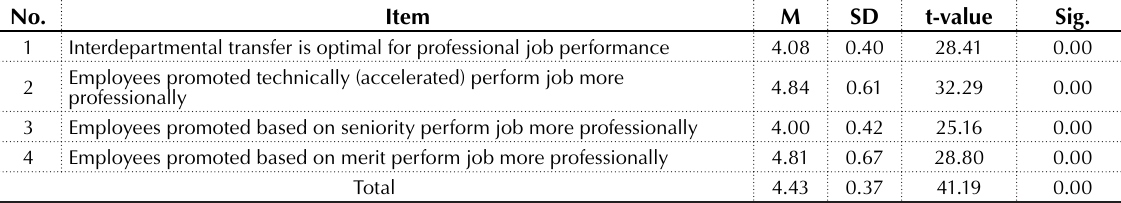
Table 3. Means, standard deviations, t-values, and significance levels of the impact of internal recruitment sources on job performance proficiency